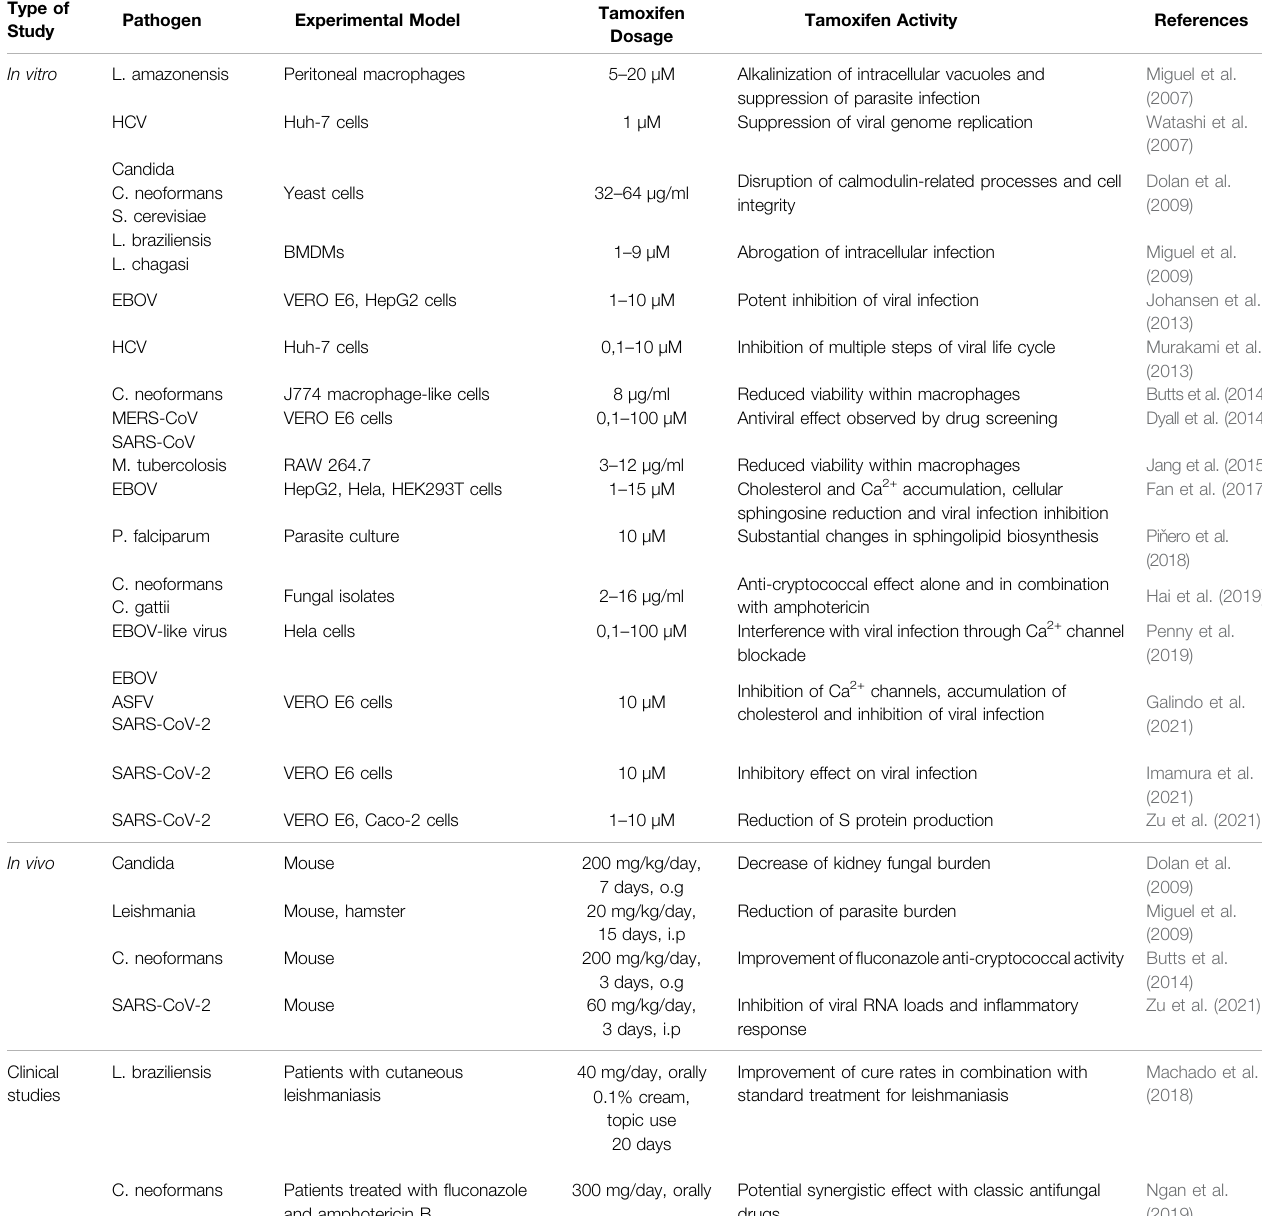
TABLE 1 | Antimicrobial activity of